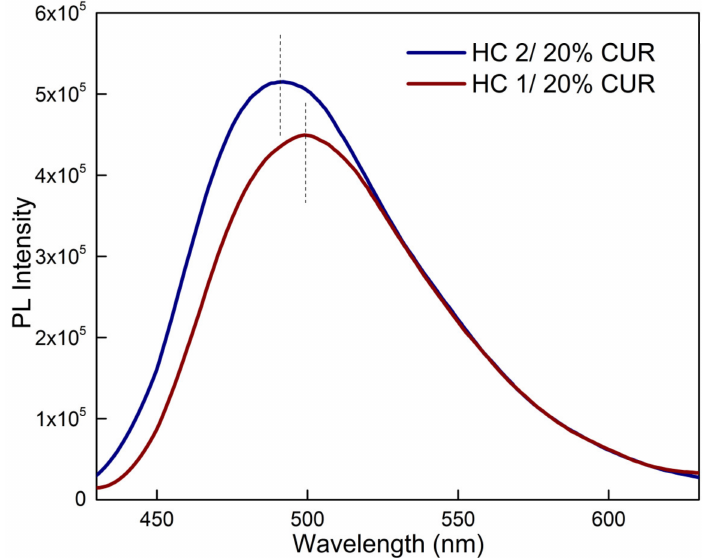
Figure 11. Fluorescence spectra of the CUR loaded PNPs.